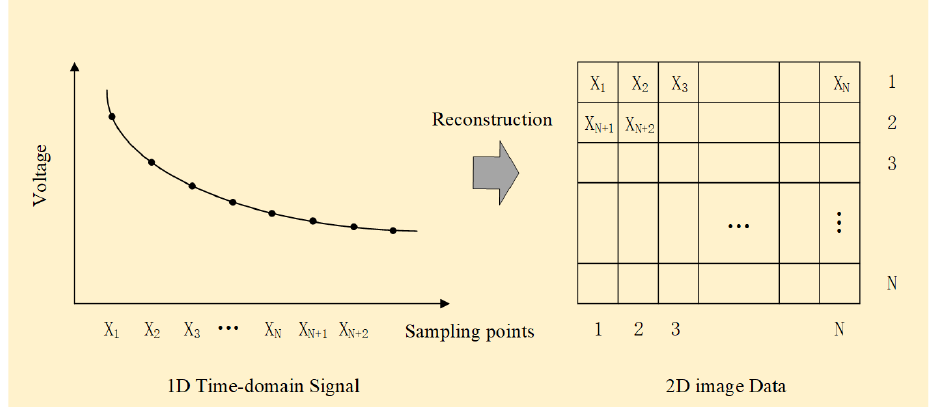
Figure 2. Illustration of 2D data generation.